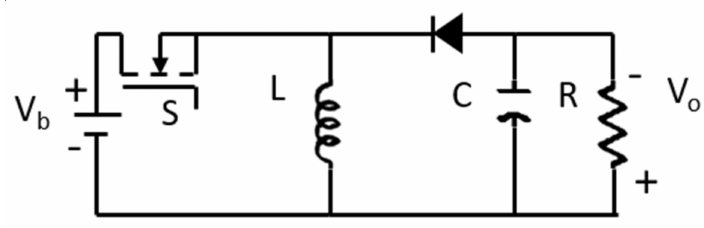
Figure 1. A diagram of buck–boost converter.